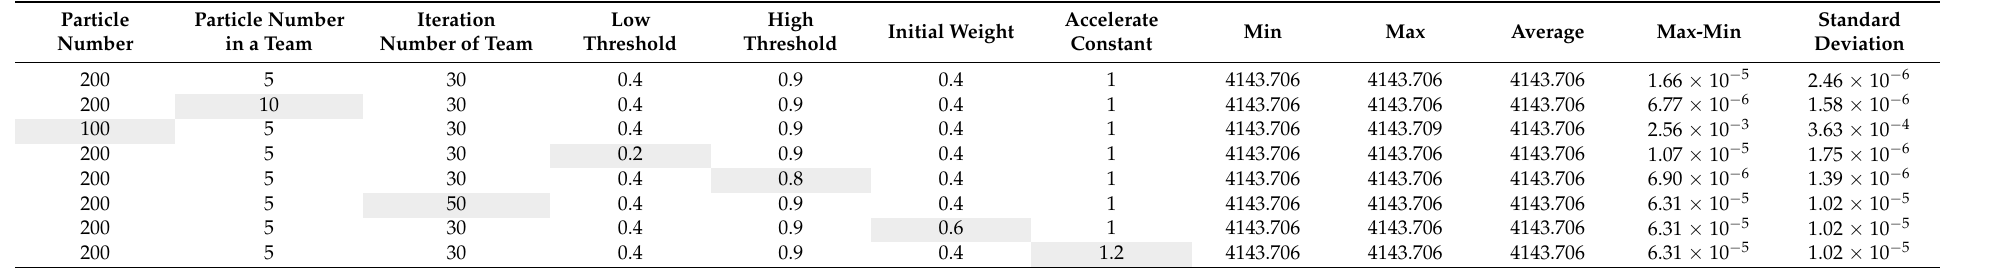
Table 7. Parameter analysis for six chillers with cooling load of 6096 RT in Case 1.